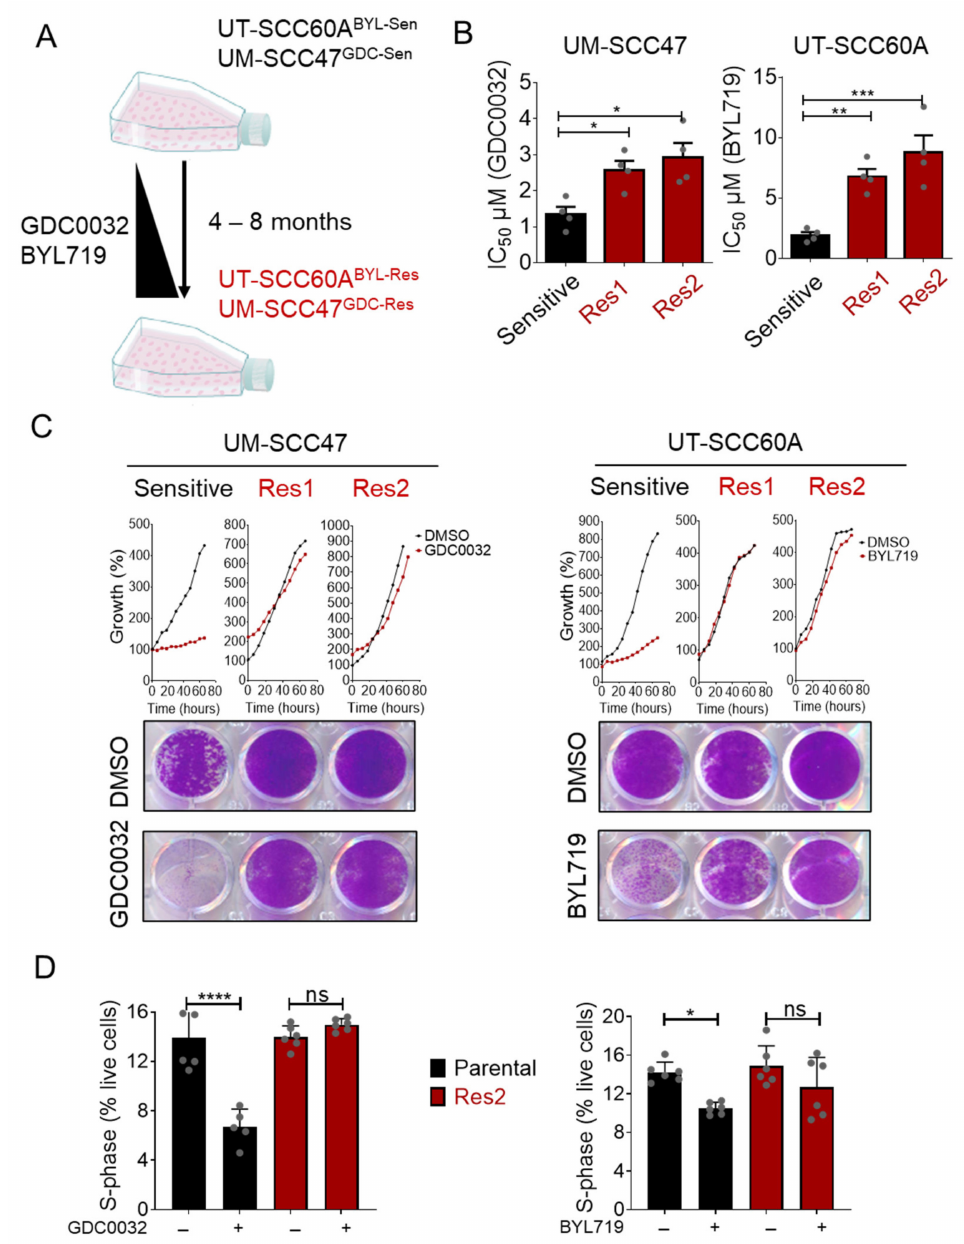
Figure 1. Generation of isiPI3K-acquired resistance HNC HPV+ cell lines. ( A ) The indicated cell lines were cultured with increasing concentrations of either GDC0032 (100 nM up to 1 µ M) or BYL719 (1 µ M up to 4 µ M) for 4 to 8 months, until resistance emerged. ( B ) One sensitive and two resistant cell lines (Res1 and Res2) of UM-SCC47 and of UT-SCC60A were cultured with DMSO and increasing concentrations of GDC0032 (0–2 µ M) or BYL719 (0–10 µ M) for 4 days. Cell viability was determined using crystal violet staining, and IC 50 values were calculated. IC 50 results of 4 separate experiments are presented as means ± SEM. Biological replicates from separate experiments are shown as grey dots. ( C ) UM- SCC47 and UT-SCC60A sensitive and resistant cell lines (Res 1 and Res2) were cultured with DMSO, GDC0032 (500 nM), or BYL719 (2 µ M) for 4 days. A live cell imager monitored cell growth every 6 h, and cell confluency was calculated. At the end of the experiment, cells were stained with crystal violet for determination of final cell densities. Each proliferation experiment was repeated 3 separate times, and a representative experiment is presented. ( D ) UM- SCC47 and UT-SCC60A sensitive and resistant cell lines (Res2) were cultured with DMSO, GDC0032 (500 nM), or BYL719 (2 µ M). Three days post-treatment, cell cycle analysis was performed, and the fraction of the cells in S-phase was determined. Cell cycle results of 2 separate experiments are presented as means ± SEM. Biological replicates from separate experiments are shown as grey dots. Statistical significance was calculated by one-way ANOVA, * p < 0.05; ** p < 0.01; *** p < 0.001; **** p <